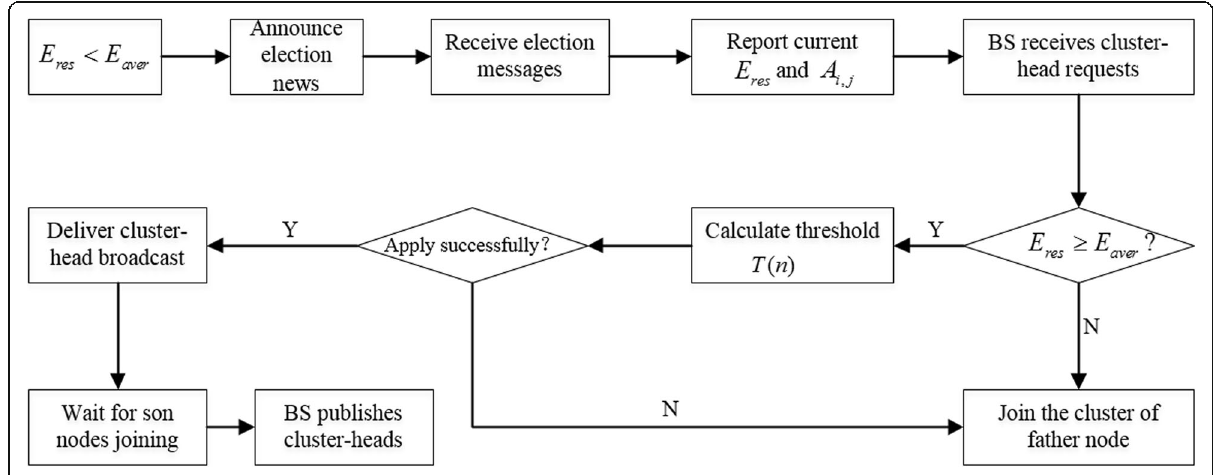
Fig. 2 The flowchart of a cluster-head competitive